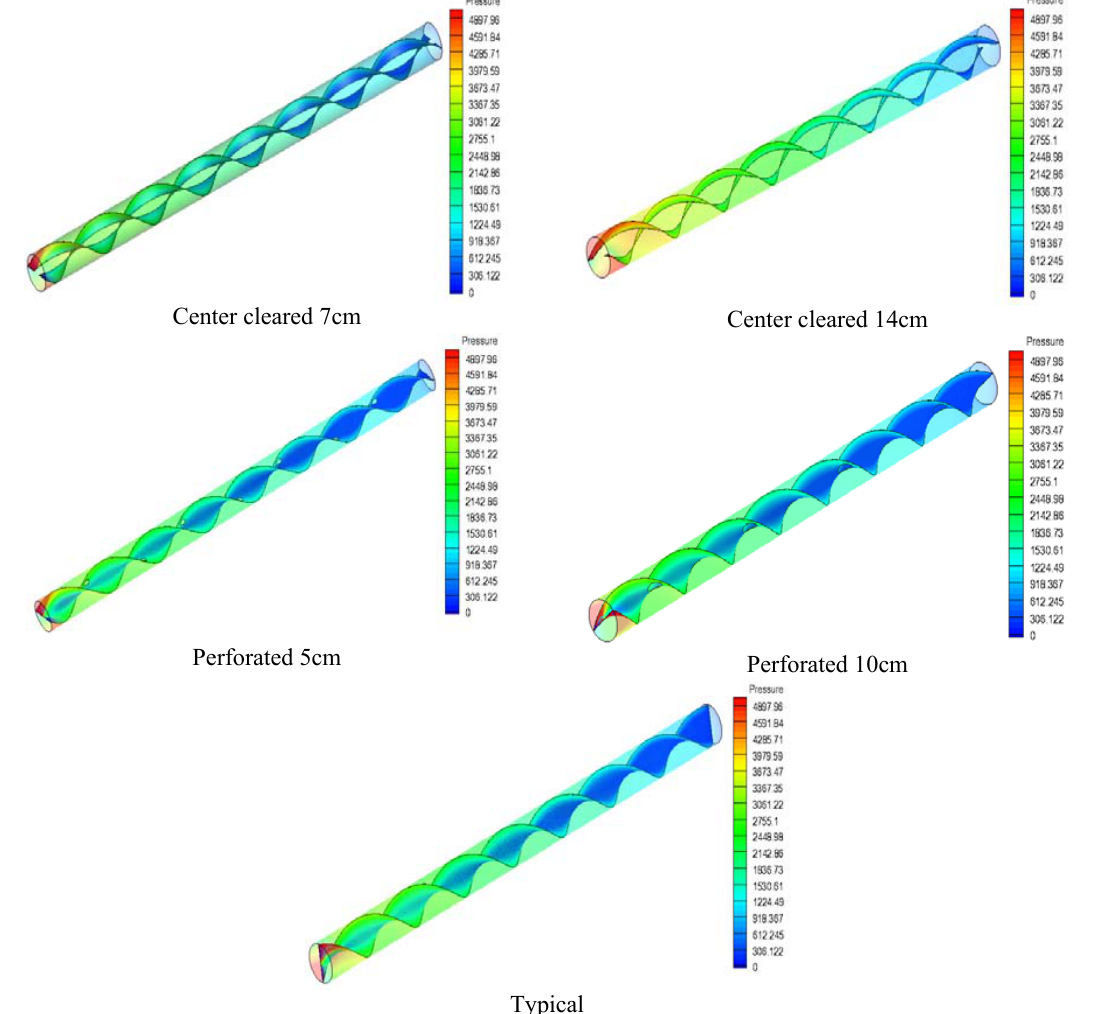
Fig. 6. The pressure contours for the five Fig. 6 The pressure contours for the five models